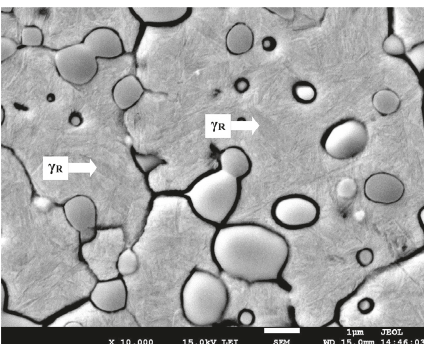
Figure 4: Detail SEM micrograph showing the microstructure of Vanadis 6 steel after SZT at 140 ° C for 24h, with particular at- tention to the matrix −